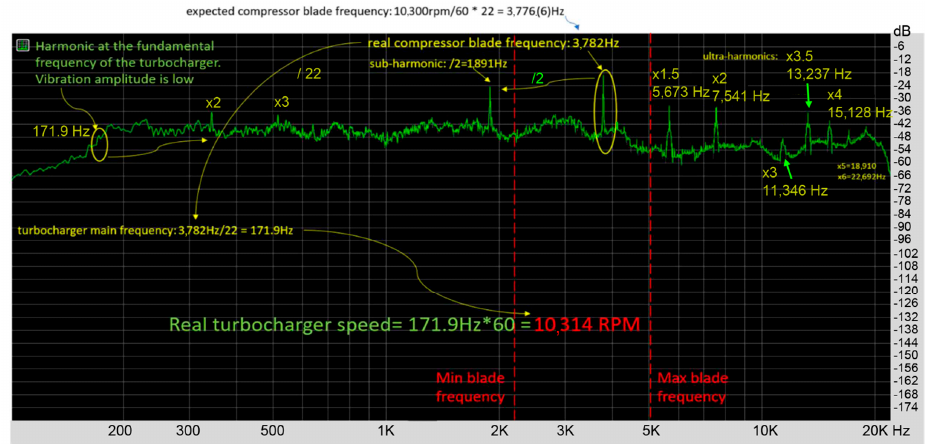
Figure 3. The acoustic signal spectrum of the TCA 66–20072 turbocharger compressor at 50% load mode of the 5S60MC engine (4500 kW, 85 rpm).